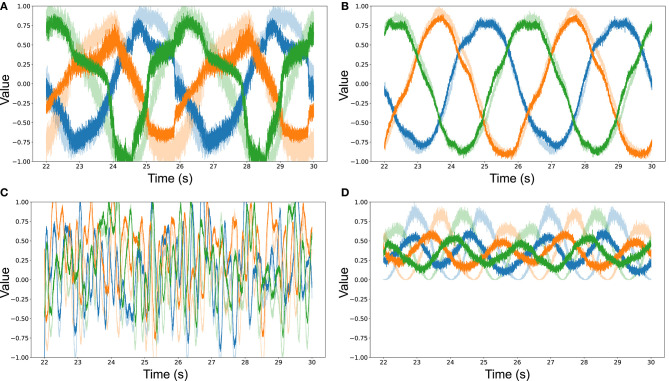
(A) Decoded output from pre- and post-synaptic ensembles of 10 neurons on a sine wave input, after being trained on a sine wave to learn to represent the identity function f (x) = x. The quality of learning is ρMSE=16.3398. (B) Decoded output from pre- and post-synaptic ensembles of 100 neurons on a sine wave input, after being trained on a sine wave to learn to represent the identity function f (x) = x. The quality of learning is ρMSE=132.9364. (C) Decoded output from pre- and post-synaptic ensembles of 100 neurons on a white noise input, after being trained on a white noise signal to learn to represent the identity function f (x) = x. The quality of learning is ρMSE=10.5064. (D) Decoded output from pre- and post-synaptic ensembles of 100 neurons on a sine wave input, after being trained on a sine wave to learn to represent the square function f (x) = x2. The quality of learning is ρMSE=12.2479.